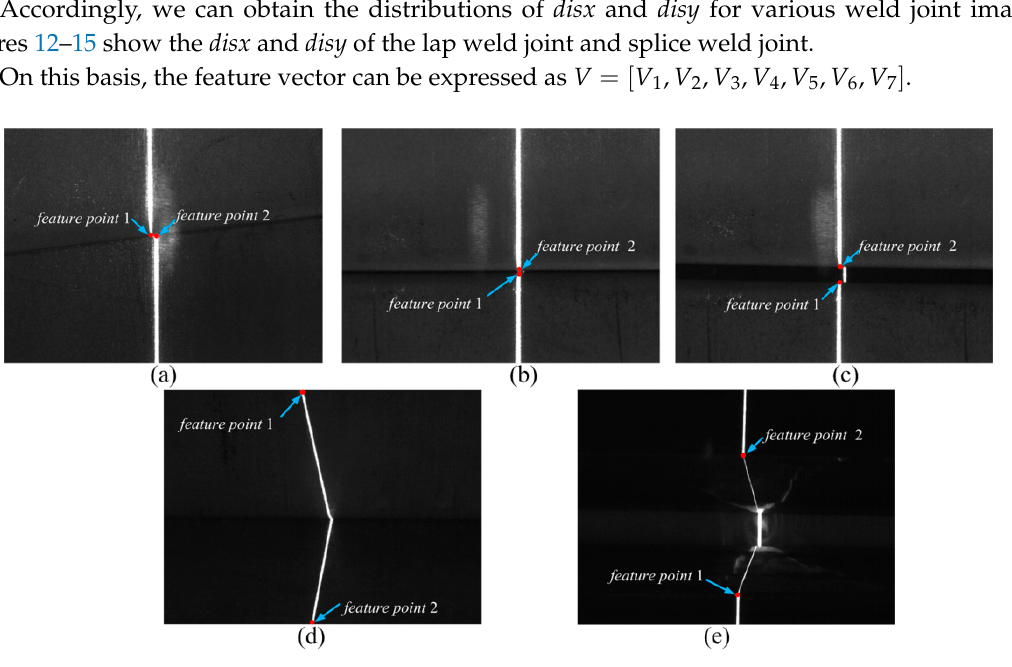
Figure 11. Feature points of weld joints: ( a ) lap weld joint, ( b ) butt weld joint, ( c ) splice weld joint, ( d ) fillet weld joint, and ( e ) v-type weld joint.